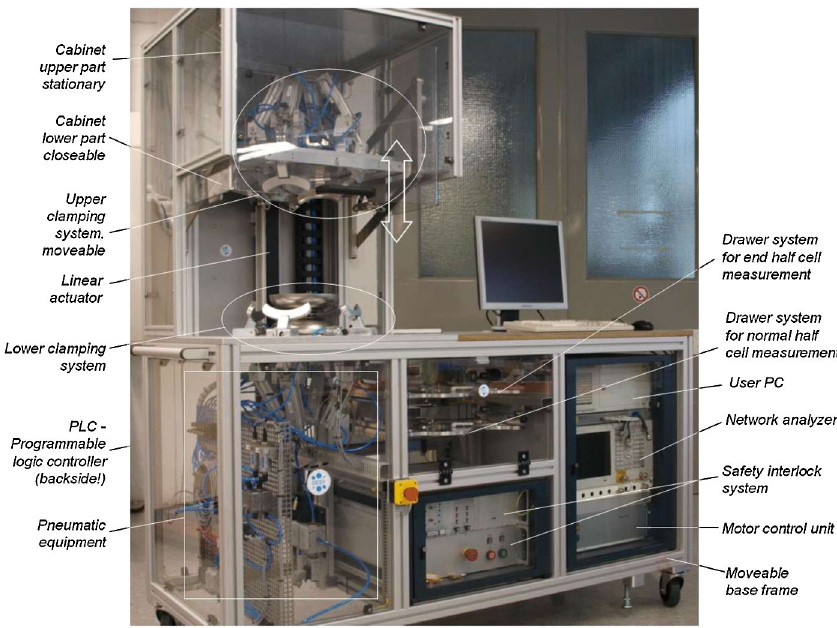
FIG. 14. Prototype rf-measurement machine (called